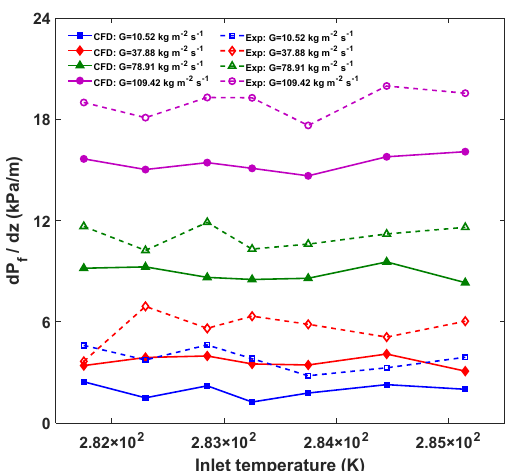
/dz and numerical dp /dz versus the inlet temperature f f